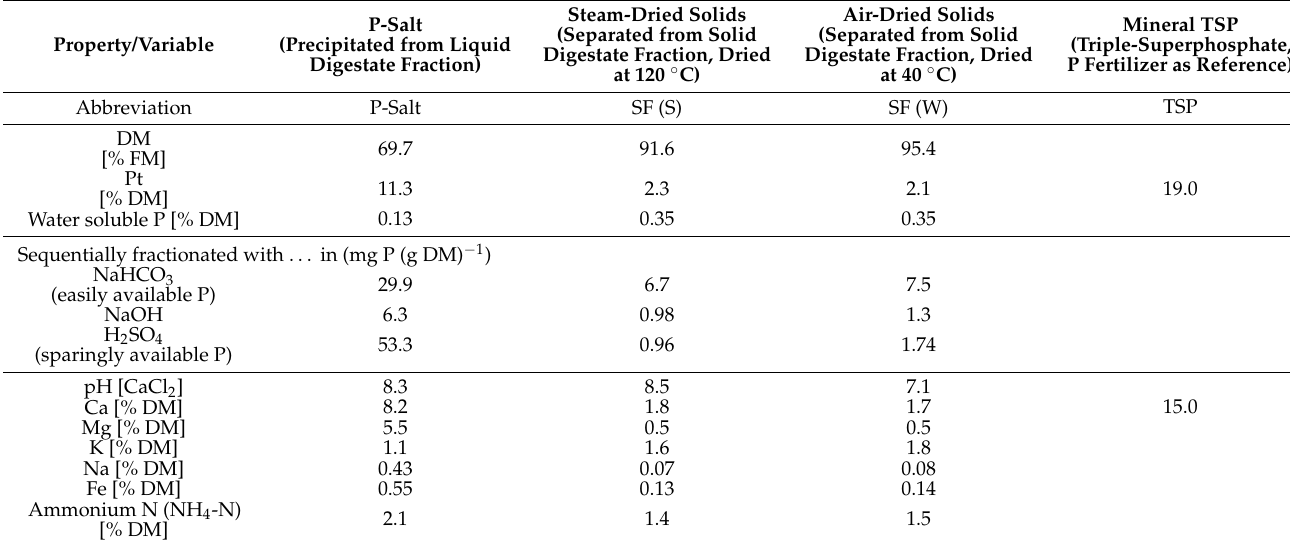
Table 1. Characteristics of phosphate salt (P-Salt) and